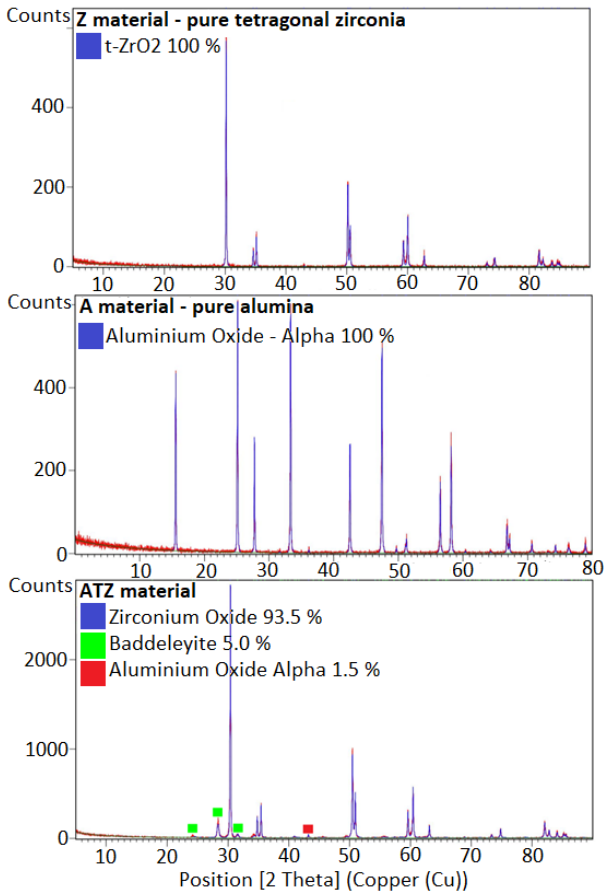
Figure 6. XRD diffraction patterns of the Z, A, and ATZ materials used for the tribological tests. For the ATZ material, the minority phases are indicated by the green and red squares.